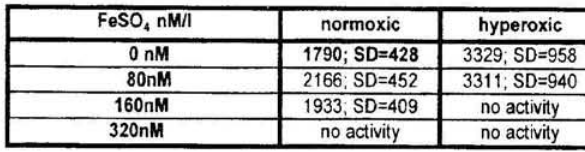
Table 2. Influence of ferric ions on tyrosine hydroxy- lase activity (cpm/mg protein) of PC 12 cells under normoxic and hyperoxic conditions. Results are based on four to six replicate experiments.